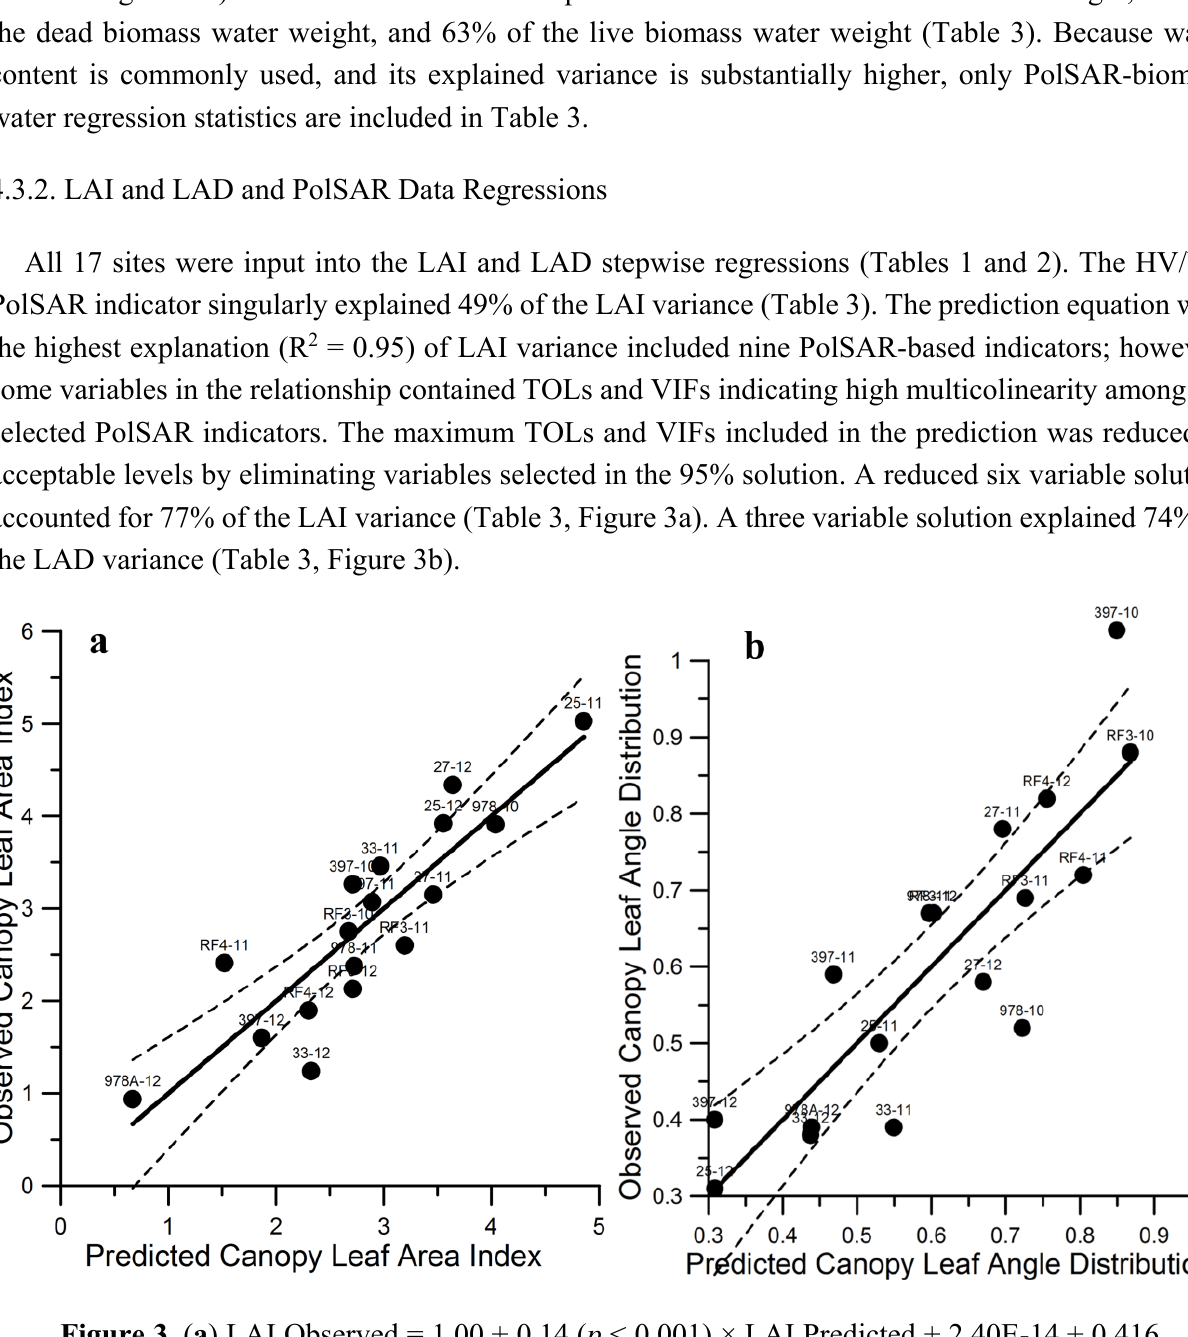
Figure 3 . ( a ) LAI Observed = 1.00 ± 0.14 ( p < 0.001) × LAI Predicted + 2.40E-14 ± 0.416 ( p = 1.0) R 2 = 0.77, Mean Square Error = 0.30 LAI, ( n = 17). ( b ) LAD Observed = 1.00 ± 0.15 ( p < 0.001) × LAD Predicted + 2.24E-14 ± 0.096 ( p = 1.0) R 2 = 0.74, Mean Square Error = 0.011 LAD, ( n = 17). Dashed line represents the 95% confidence